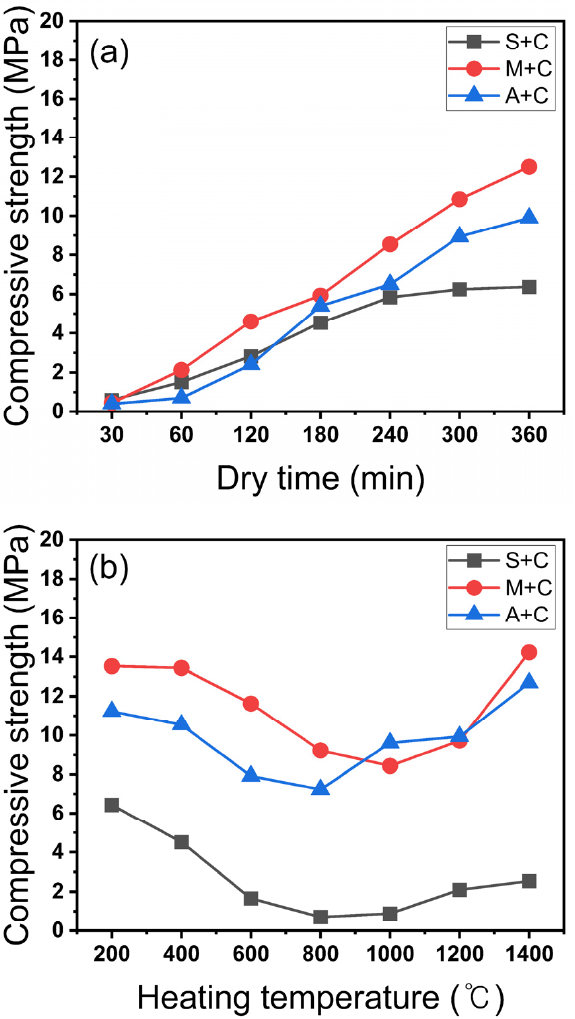
Figure 4. ( a ) Uniaxial pressing strength by time taken for simple molding, ( b ) Compressive pressing strength by heat treatment temperature.